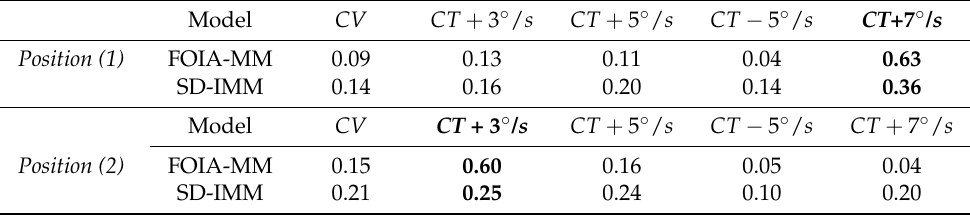
Figure 12. RMSE of position (m) and velocity (m/s); ( σ 2 = 40 m ), distance between the true position and the obstacle areas. Table 5. Model probabilities of Position (1) and Position (2).